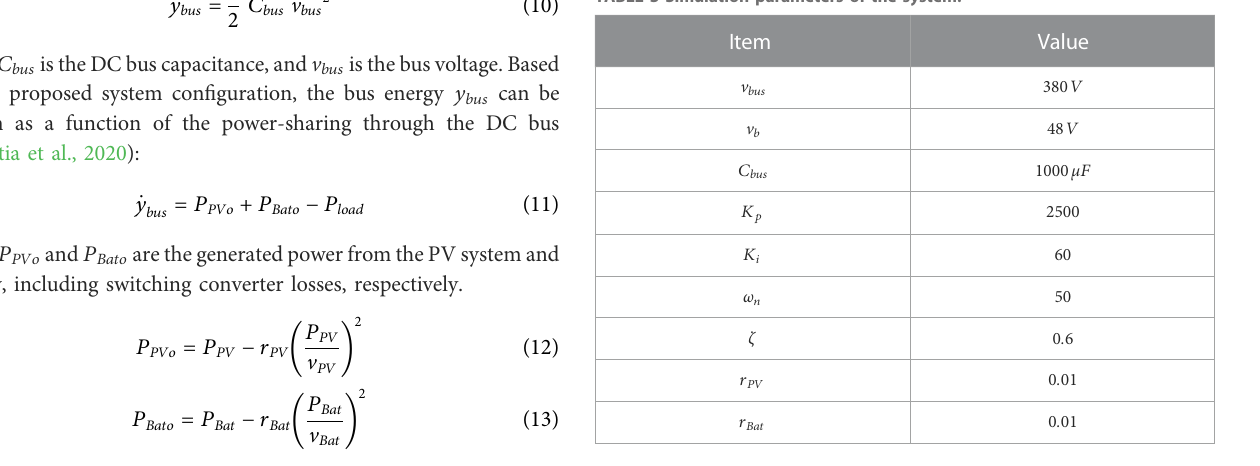
TABLE 3 Simulation parameters of the